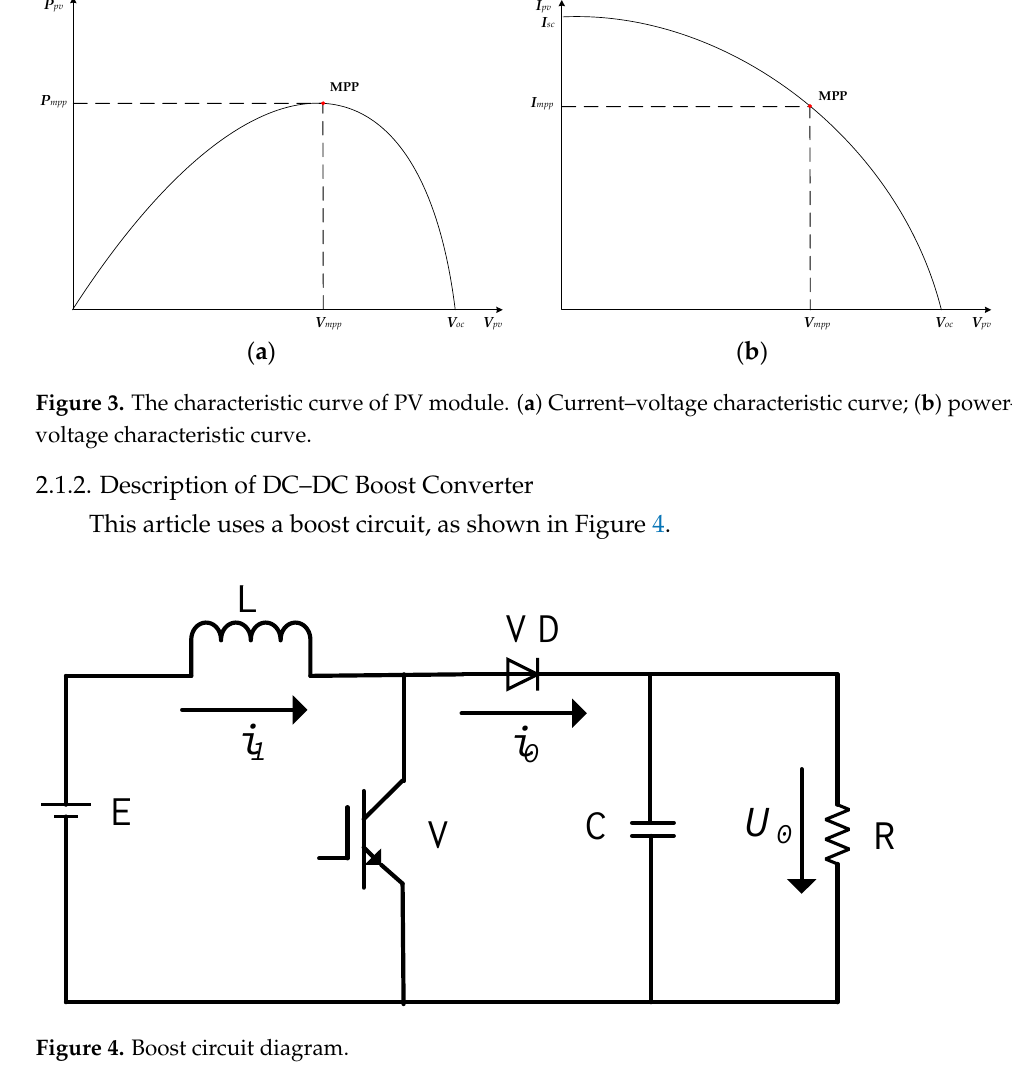
Figure 4. Boost circuit diagram.